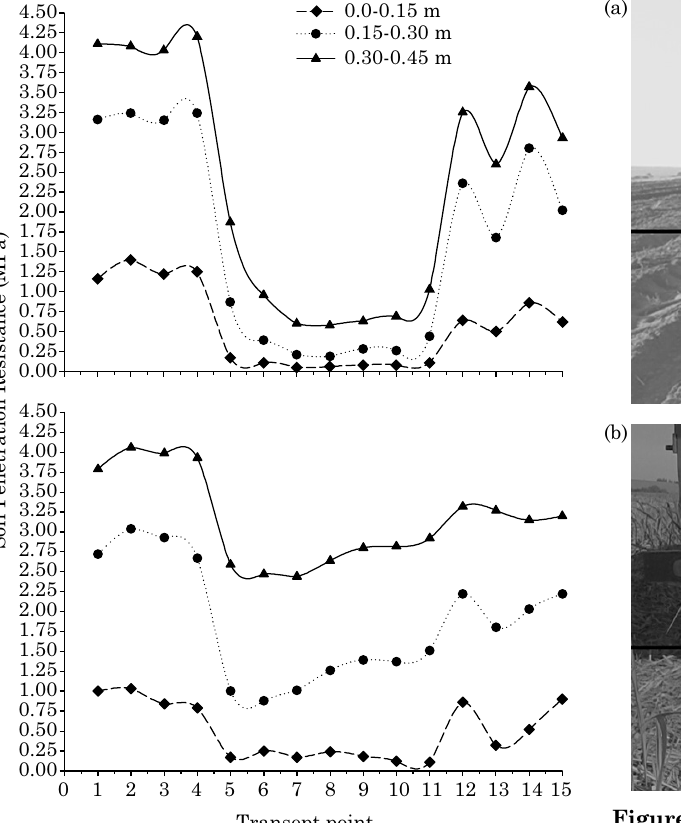
figure 3. Soil cone index curves for the layers (0.00-0.15, 0.15-0.30 and 0.30-0.45 m), for in-row deep tillage (a) and for conventional tillage (b) in